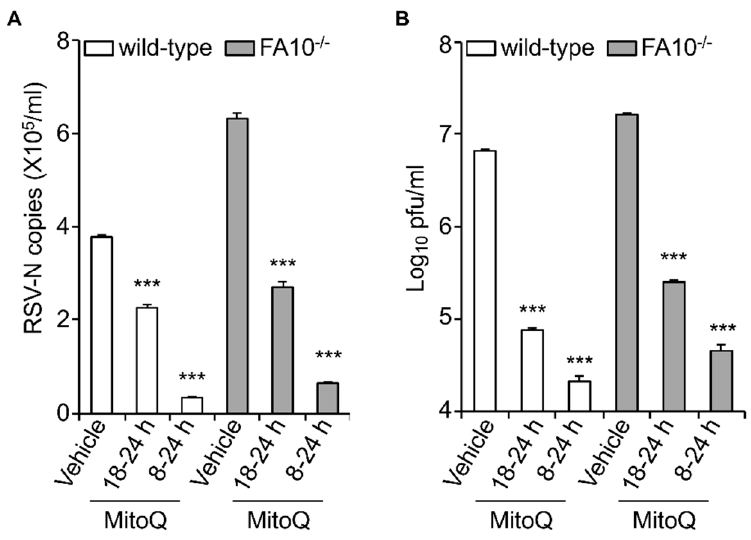
Figure 5. The mtROS scavenger mitoquinone mesylate (MitoQ) protects against RSV infection in human embryonic kidney cells. RSV-infected (MOI 1) wild-type or FA10 − / − HEK293T cells were treated with MitoQ (1 μ M) for the times indicated, followed by cell lysate preparation, with ( A ) qPCR and ( B ) plaque assay performed to determine the viral RNA copy number and infectious virus (plaque forming units pfu/mL), respectively. Results shown represent the mean ± SEM ( n = 3 independent experiments, each performed in triplicate). Two-way analysis of variance (ANOVA) analysis was performed. *** p < 0.001 compared to the vehicle-treated respective cell lines. RSV genome copies and virus production levels were also statistically significant between wild-type and FA1 − / − HEK293T cells (*** p < 0.001).